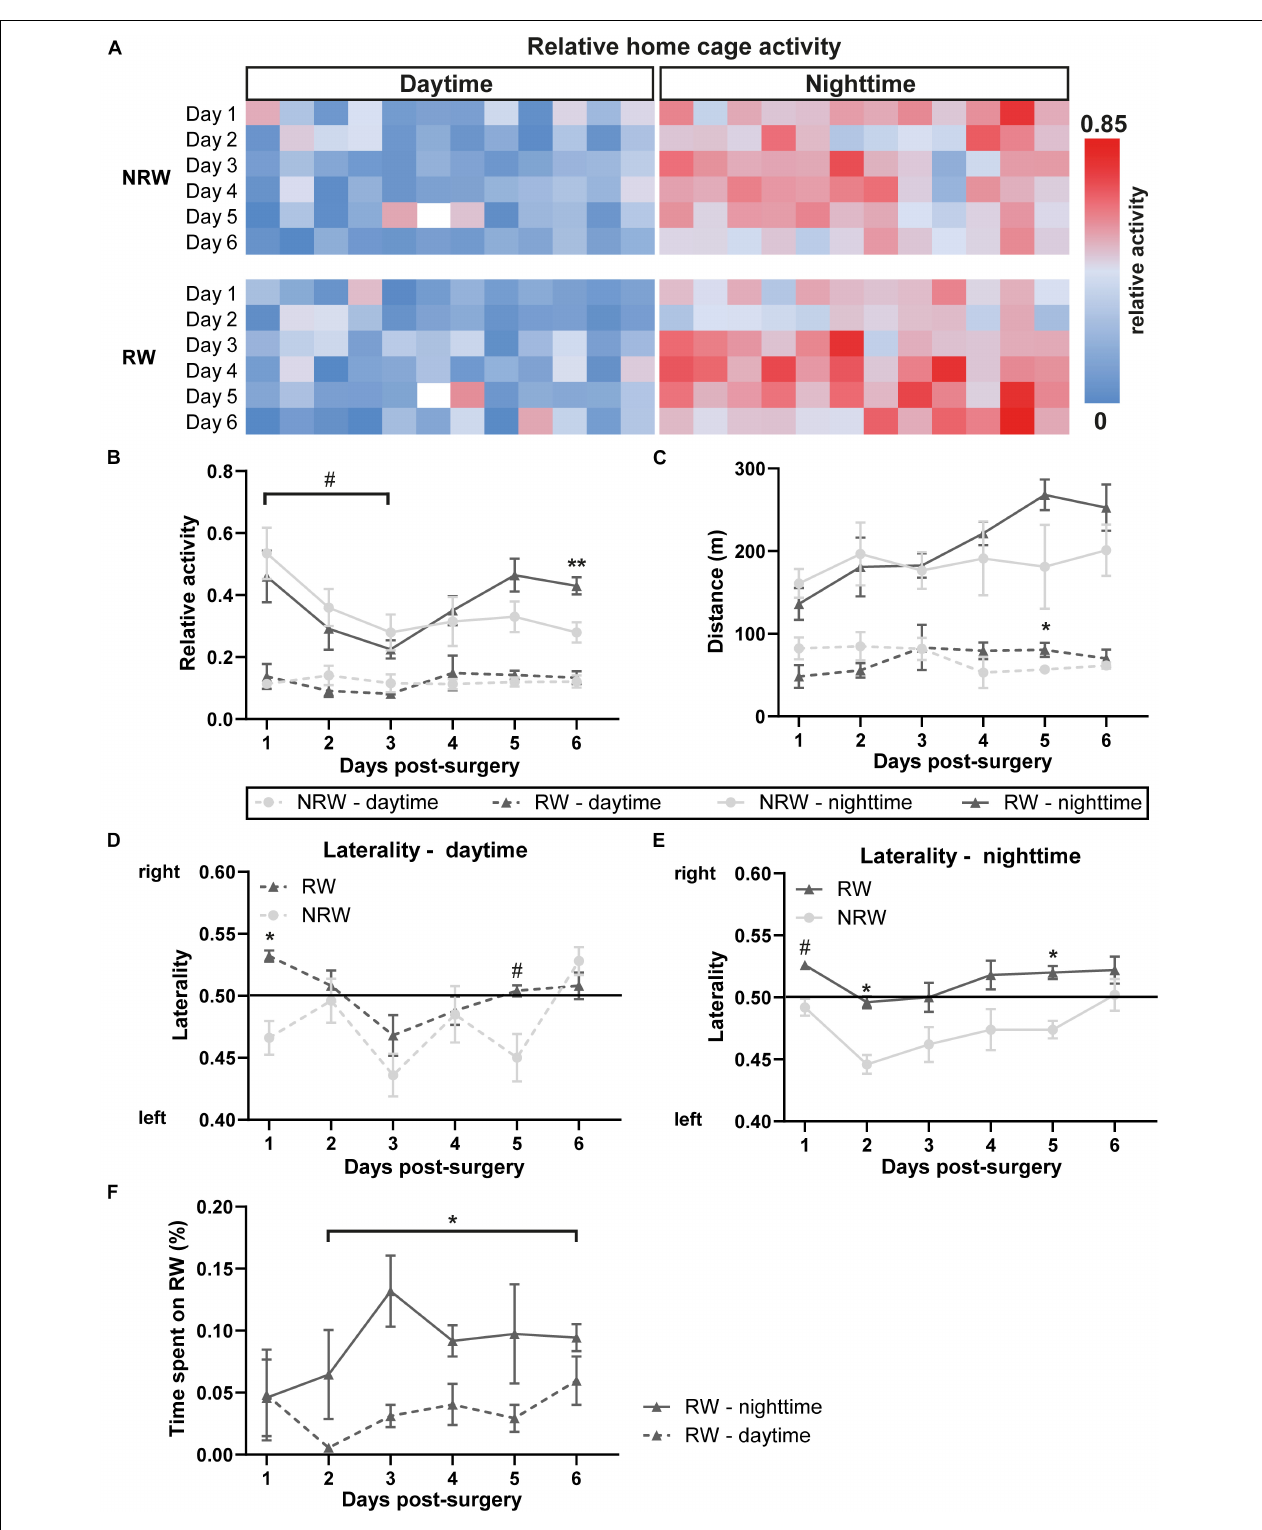
FIGURE 3 | (A) Heatmaps showing average home cage activity per hour in RW and NRW mice recorded during 6 days post-surgery. Mice were exposed to a 12 h light cycle. DVC activity metrices were measured in RW and NRW mice during 1 week post-stroke, including (B) relative home-cage activity (day- and nighttime), (C) walked distance inside the home-cage (day- and nighttime), (D) daytime and (E) nighttime laterality index, and (F) the relative time spent on the running wheel. RW: N = 5, NRW: N = 5; values represented in mean ± SEM. # 0.05 < p < 0.08 (tendency); * p ≤ 0.05; ** p ≤ 0.01.